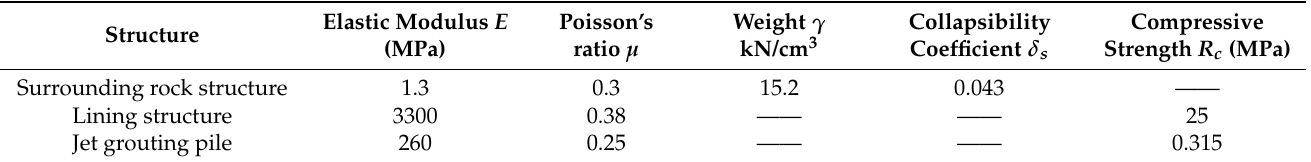
Table 2. Mechanical parameters of model structure